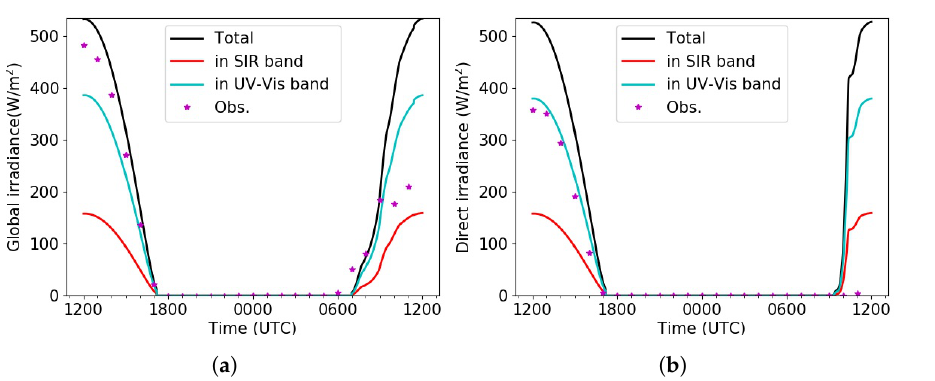
Figure 4. Same as Figure 2: global solar ( a ) and direct solar ( b ) irradiances for the SIR, UV-Vis